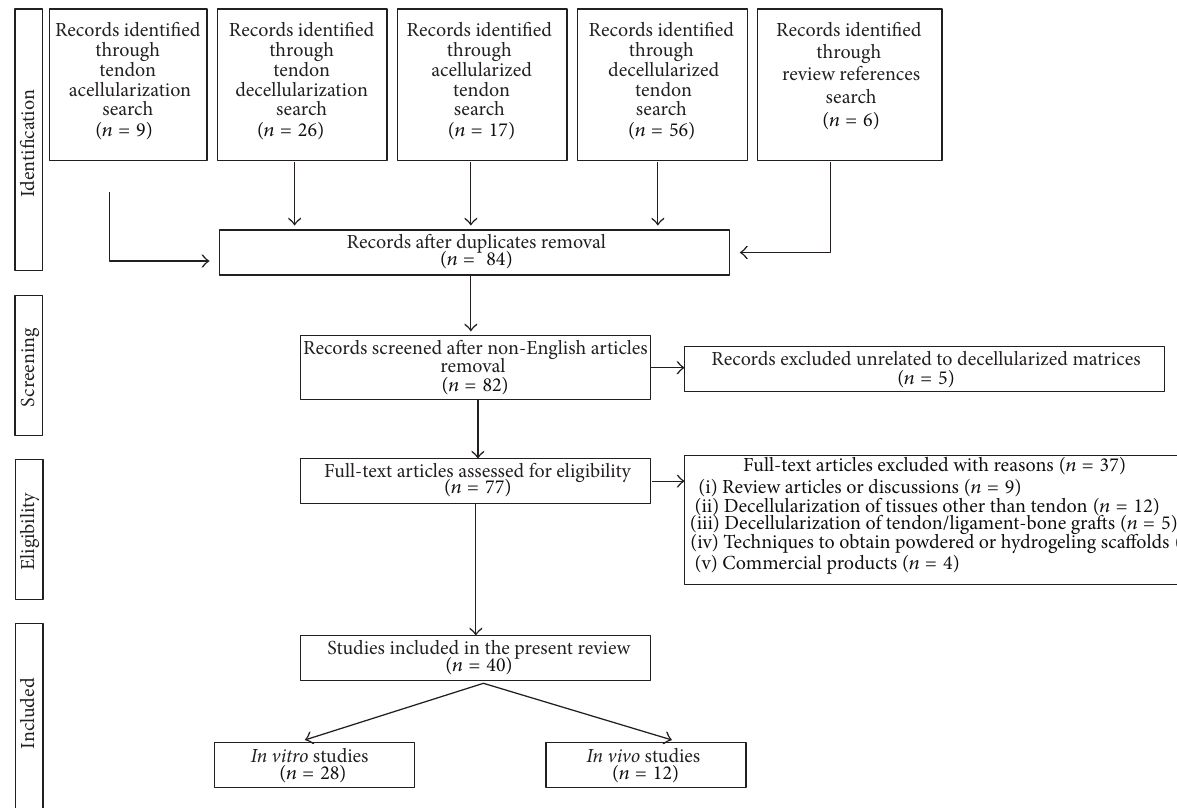
Figure 2: Research strategy. Flow chart of selection